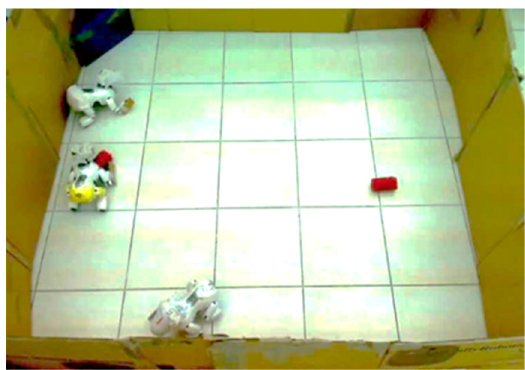
Figure 4. Sony AIBO robots foraging red items.